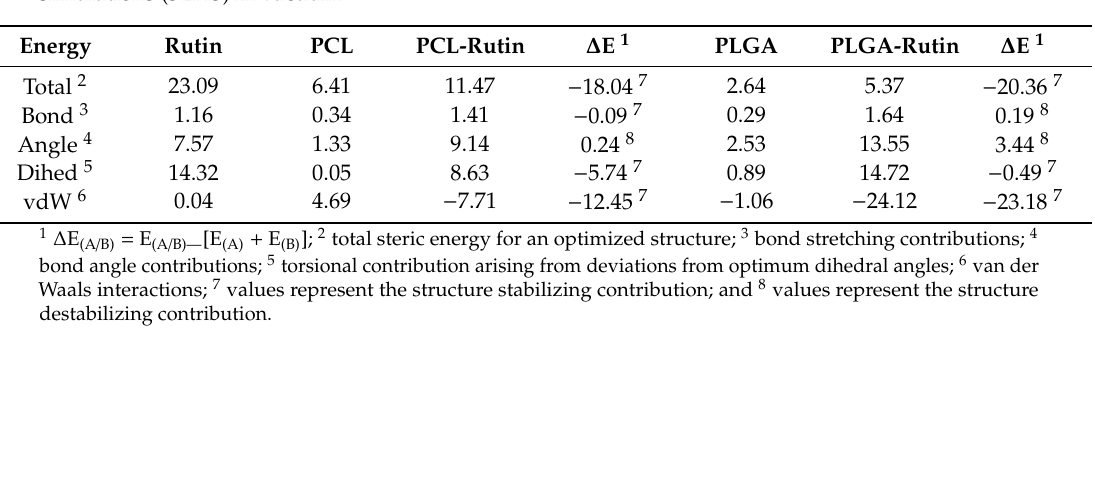
Table 1. Inherent energy attributes of polymer-rutin complexes calculated using static-lattice atomistic simulations (SLAS) in